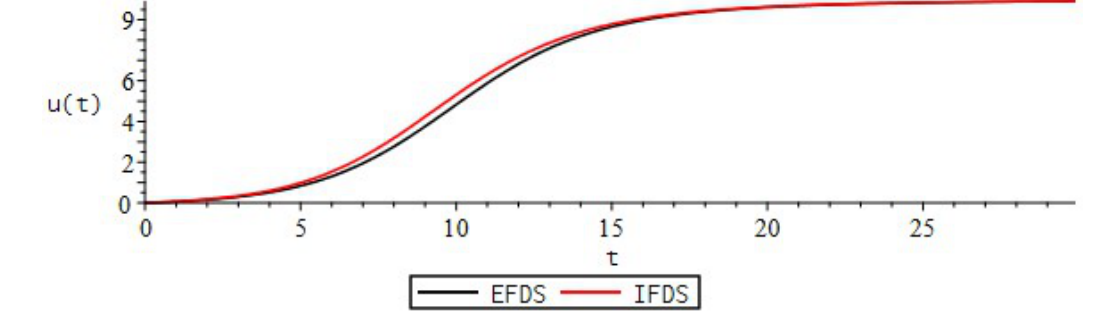
Figure 1. Numerical solutions of the fractional Riccati equation with constant coefficients and α = 0.9 taking into account the fulfillment of the condition.